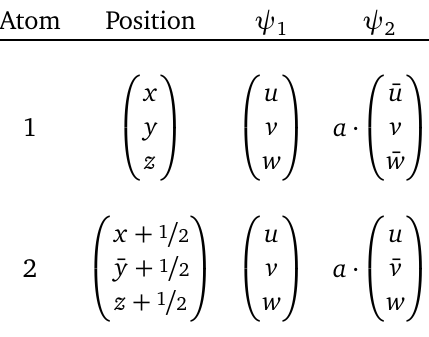
Table 4: Basis vectors ψ of the irreducible representation Γ for each of the Fe sites n n of CaBaFe O for space group Pbn2 and propagation vector q = ( 1 / 3 0 0). Note 4 7 1 that each of the Fe sites splits into two orbits. The phase factor a = exp ( 2 π i qr ) results from the n glide plane perpendicular to the b axis with translation vector r = ( 1 / 2 0 1 / 2 ).